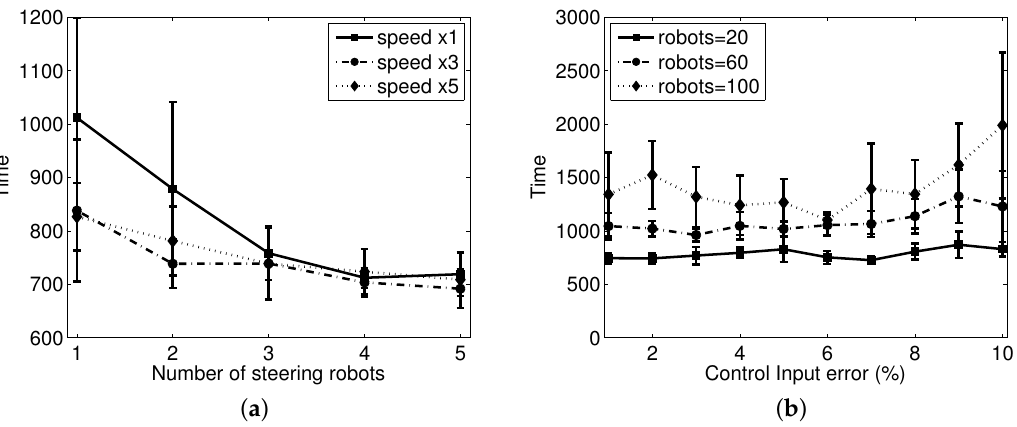
Figure 8. Results with the change in the speed of steering robots: ( a ) time to reach the goal area vs. the speed of the steering robot and ( b ) time vs. control input error.